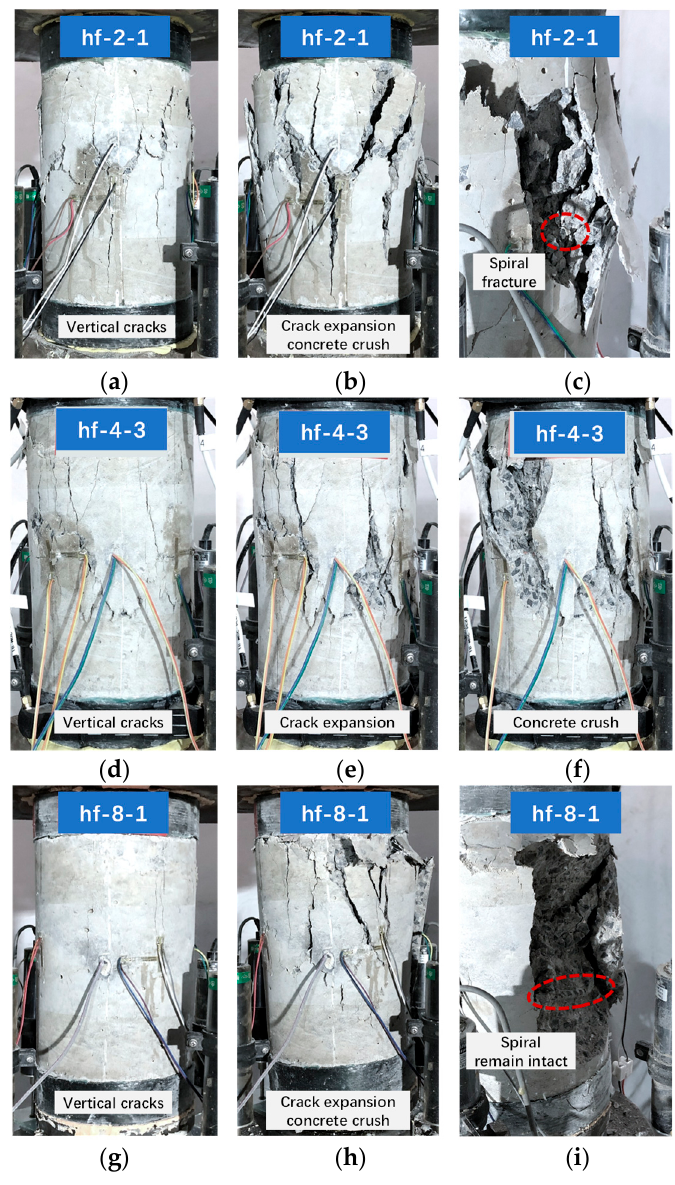
Figure 5. Typical failure process of hf series cylinders: ( a ) hf-2-1(i), ( b ) hf-2-1(ii), ( c ) hf-2-1(iii); ( d ) hf-